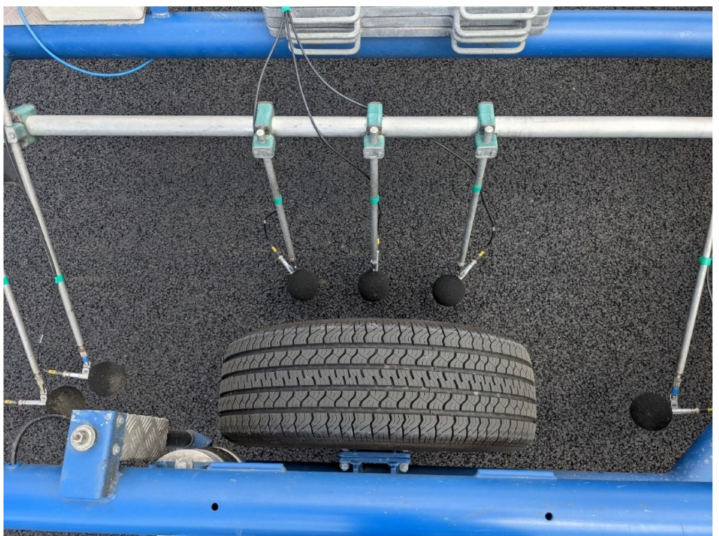
Figure 2. Positioning of the microphones around the reference tyre, photo 2021 (source: